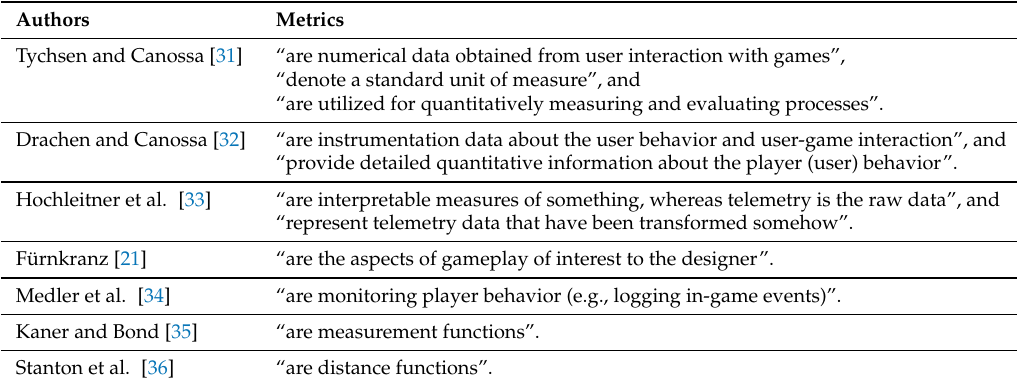
Table 1. Key aspects of metric definitions extracted from the